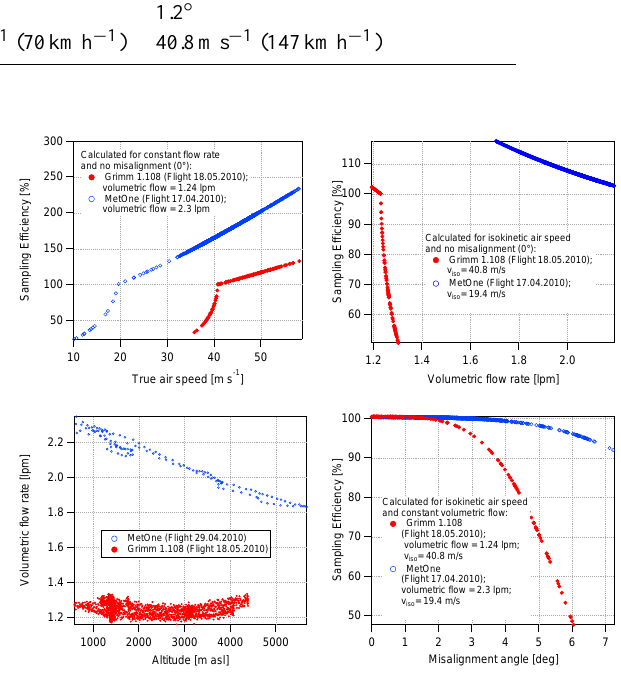
Fig. A5. Modeled sampling efficiency for D a = 4µm particles with a density of 2.65gcm − 3 , as function of the true air speed, misalign- ment angle of the isokinetic sampling tip (Grimm OPC: inner diam- eter 0.8mm; MetOne OPC: inner diameter 1.59mm) and the volu- metric flow rate, calculated for in-flight data measured by the two optical particle counters used on board of the DIMO research air- craft. The left bottom plot shows the measured altitude dependence of the volumetric instrument flow rate. The displayed sampling effi- ciencies include the aspiration efficiency as well as eddy formation for super-isokinetic sampling (von der Weiden et al., 2009).